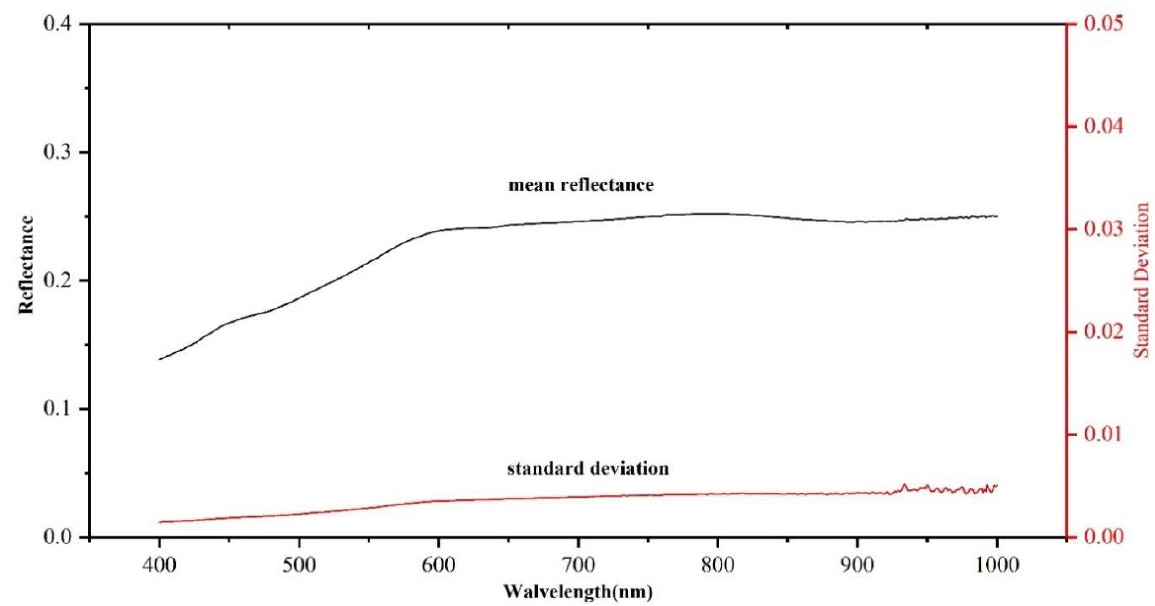
Figure 14. Surface reflectance and standard deviation of the Gobi Desert at the Dunhuang test site.